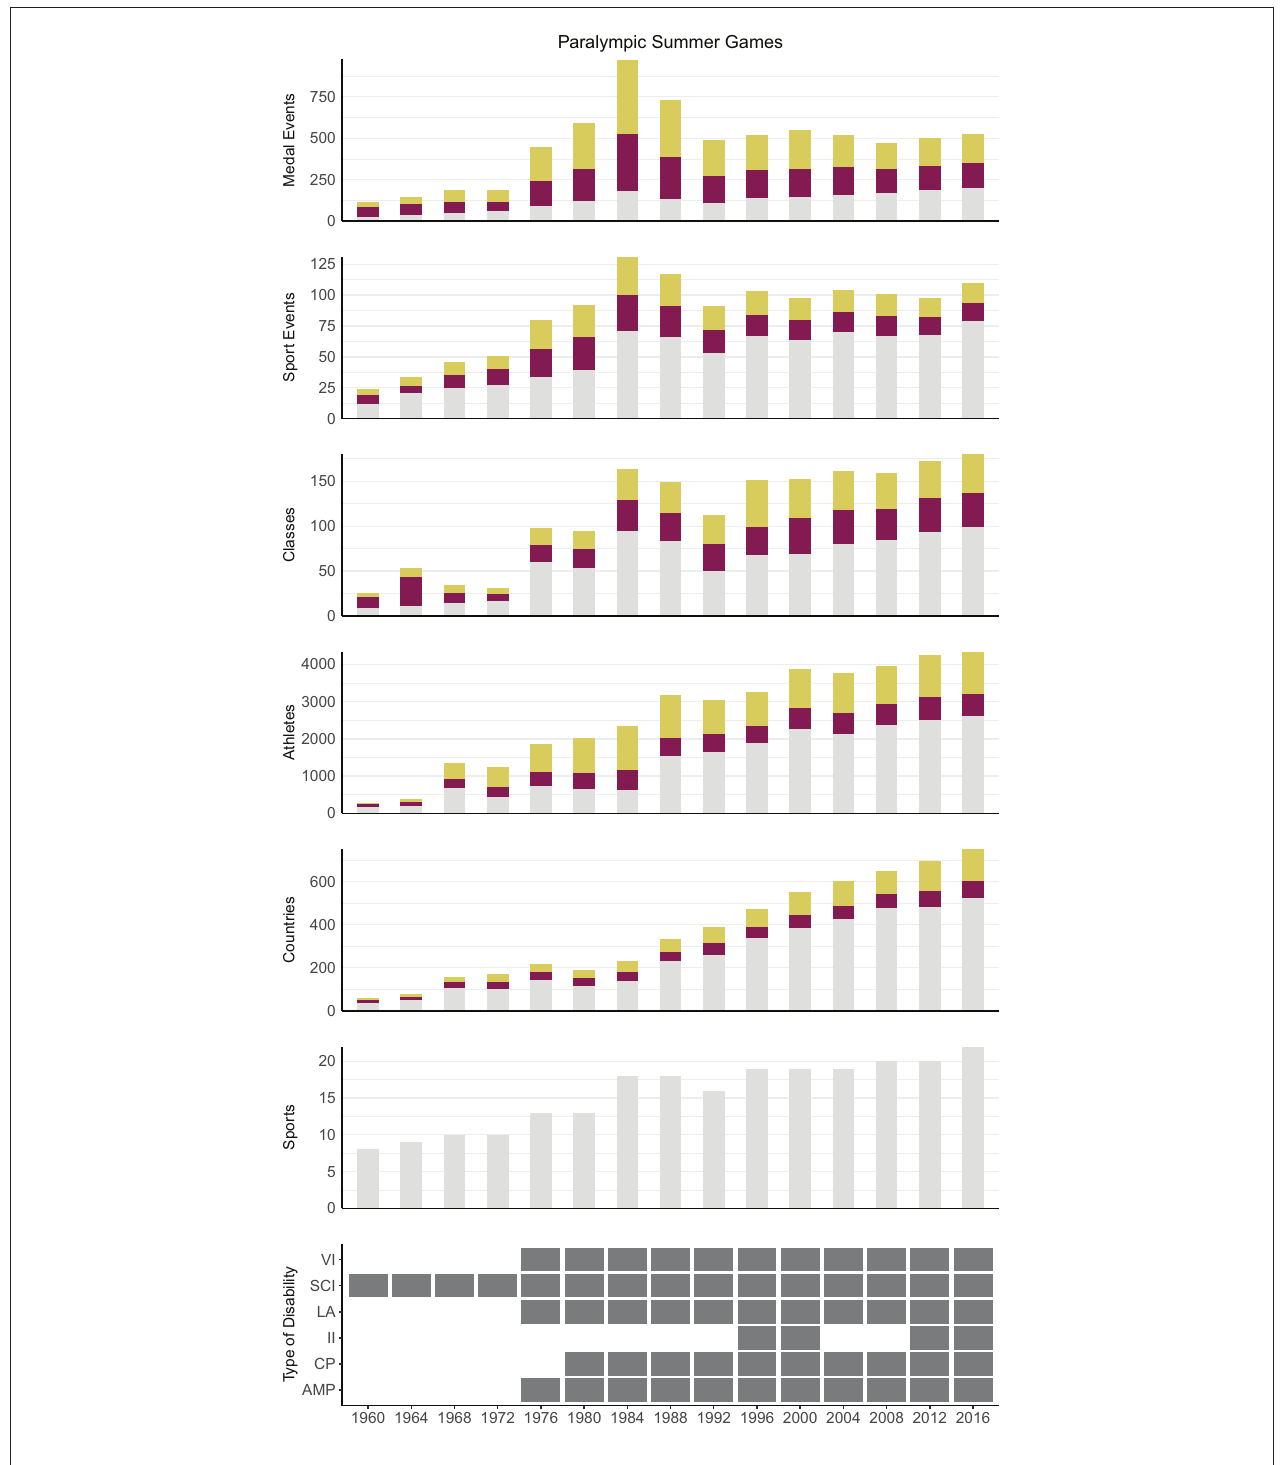
FIGURE 1 | Schematic overview showing the contribution of swimming and athletics to the total number of medal events, sport events, and classes during each of the Paralympic Summer Games. Some sports have the same division of classes; in these cases, the number of classes is counted once per sport. In addition, some athletes and countries participated in more than one sport; in these cases, the number of athletes and countries were counted once per sport. VI, visual impairment; SCI, spinal cord injury; other impairments (LA, les autres); II, intellectual impairment; CP, cerebral palsy; AMP, amputation. For the number of unique countries, (see Table 2